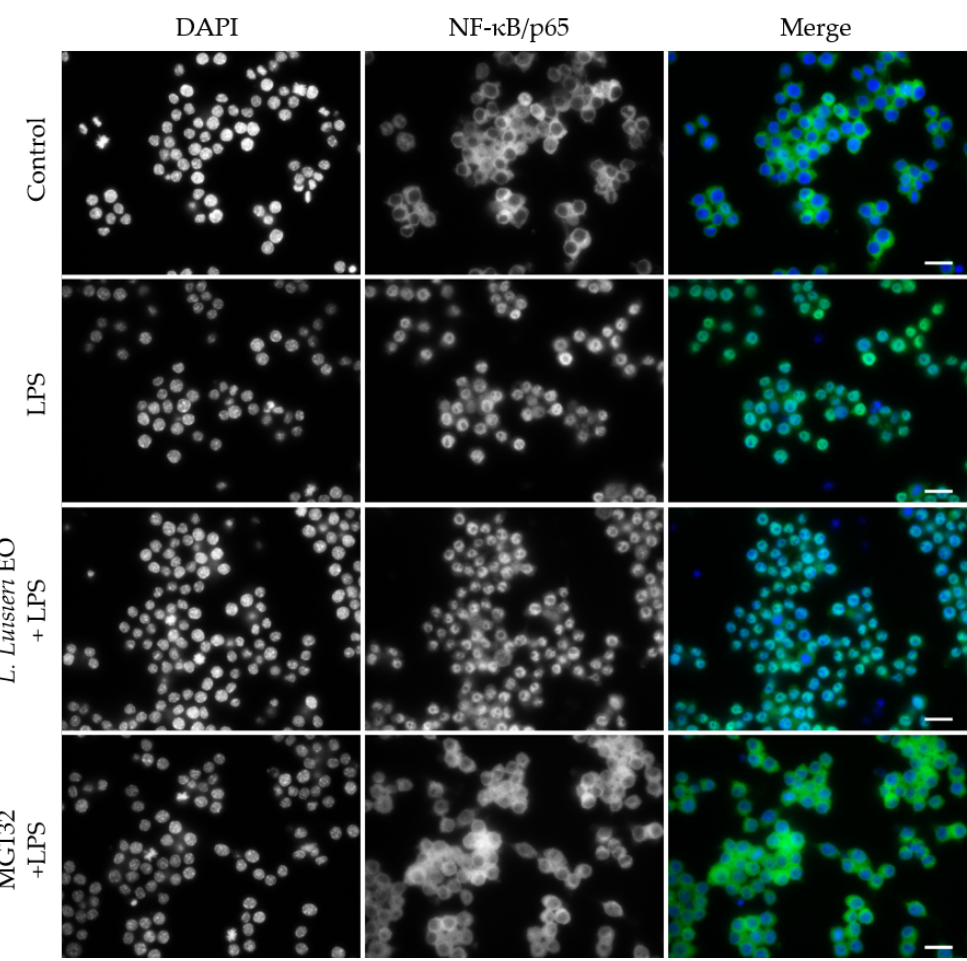
Figure 6. Inhibitory effect of Lavandula luisieri essential oil (EO) on NF- κ B/p65 nuclear translocation. Macrophages were incubated on µ -slides and pre-treated with MG-132 (10 µ M) for 1 h and, then, treated with 1 µ g/mL LPS for 20 min, alone or in combination with the essential oil (0.32 µ L/mL) or MG-132. Control cells (Ctrl) were left untreated. Immunofluorescence staining of NF- κ B/p65 (green) was performed as detailed in the Materials and Methods section and DAPI (blue) was used as a counter stain. Representative images of each condition are shown. Scale bar: 20 µ